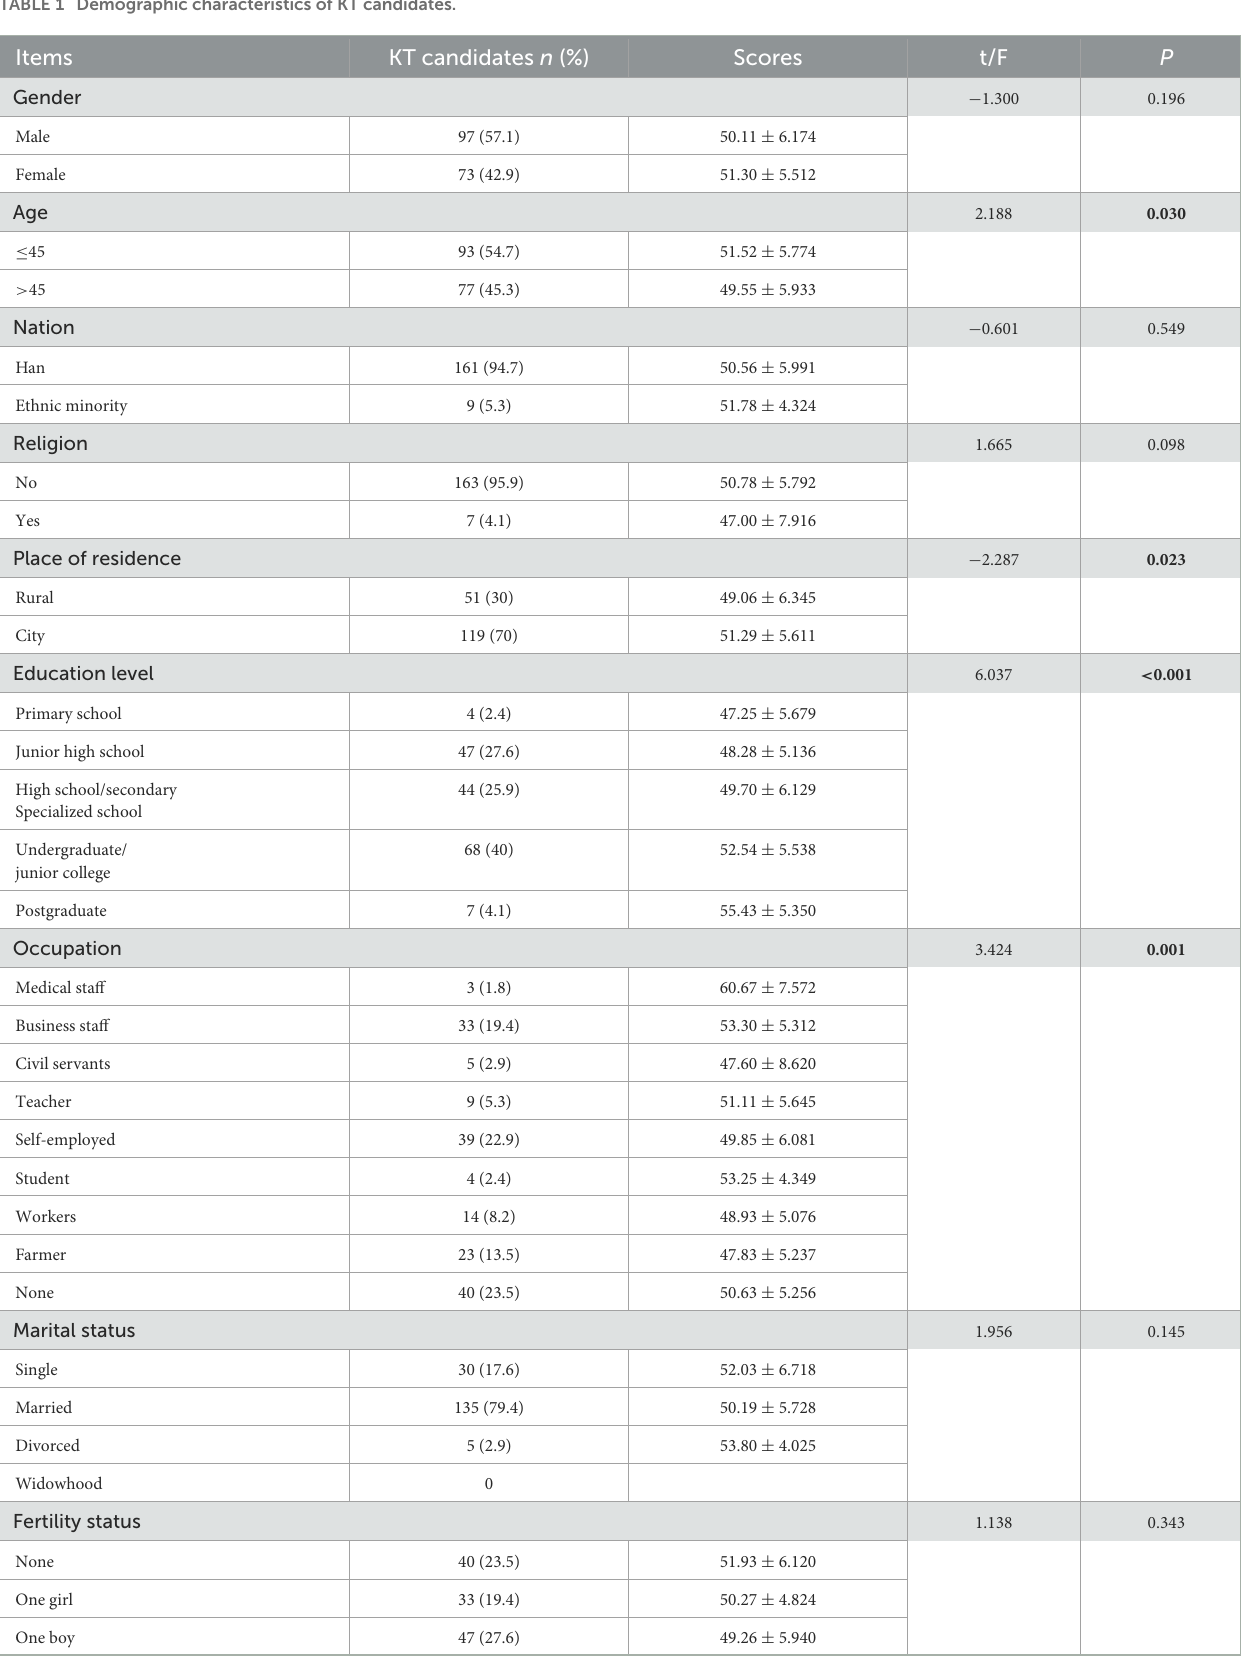
TABLE 1 Demographic characteristics of KT